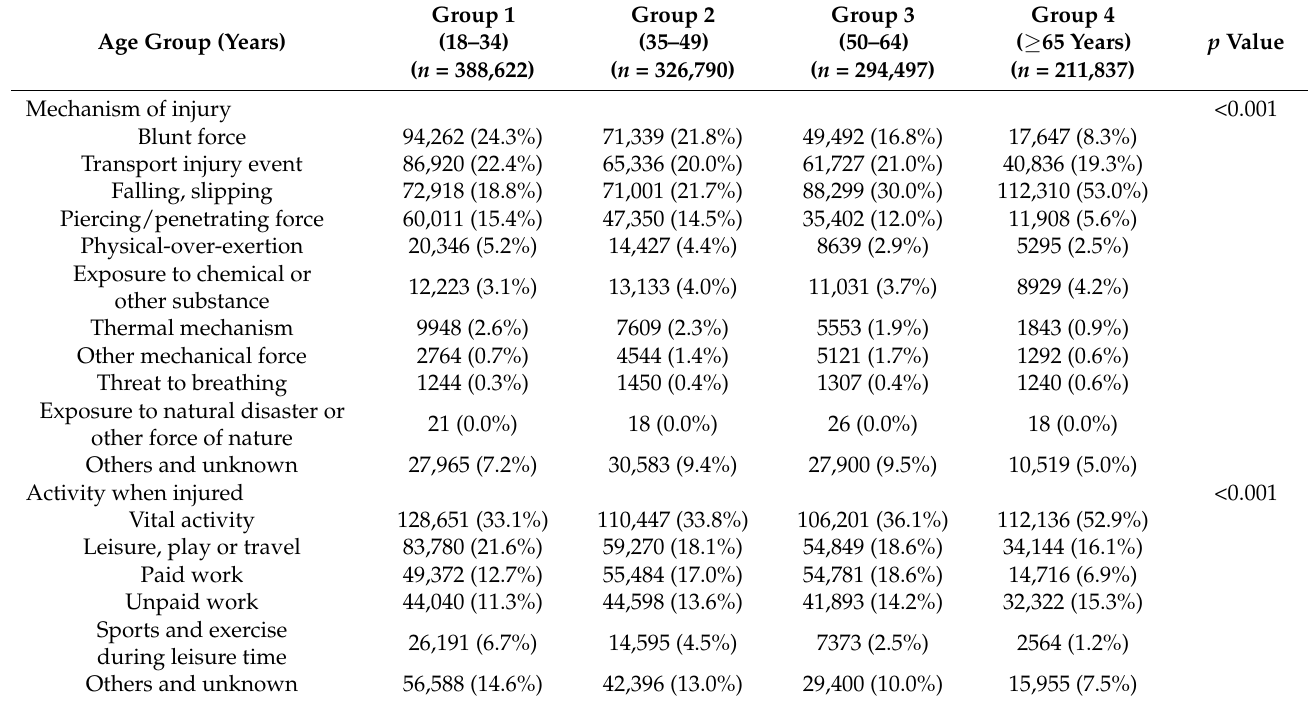
Table 2. Mechanism and activity when injured of injury patients by age